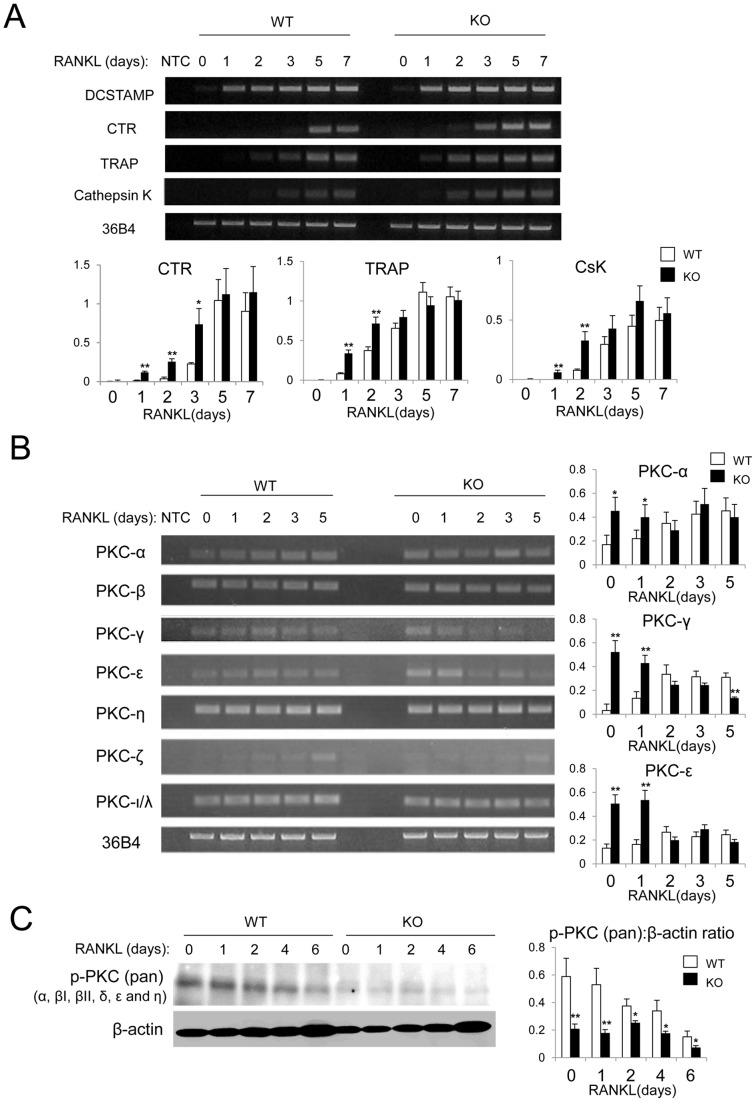
Altered gene expression profile in PKC-δ KO osteoclast cultures.BMMs from WT and PKC-δ KO mice were stimulated with 100 ng/ml of RANKL for the indicated times (0, 1, 2, 3, 5 and 7 days). Total RNA was extracted for RT-PCR. (A) Gene expression of osteoclast specific genes: DC-STAMP, Calcitonin receptor (CTR), Tartrate-resistant acid phosphatase (TRAP), Cathepsin K (CsK) and reference gene 36B4. Quantitative gene expression relative to 36B4 as determined by densitometry of agarose gel images. NTC, no template control. (B) PKC-δ KO BMM showed altered gene expression of PKC isoforms during RANKL-induced osteoclastogenesis. Quantitative gene expression relative to 36B4 of PKC-α, PKC-γ and PKC-ε by densitometry of agarose gel images. (C) Western blot analysis showing that the phosphorylation levels of PKC isoforms were reduced in PKC-δ KO osteoclasts compared to WT. Statistical analysis was performed by comparing to WT in each time point. *, p-value <0.05. **, p-value <0.01.